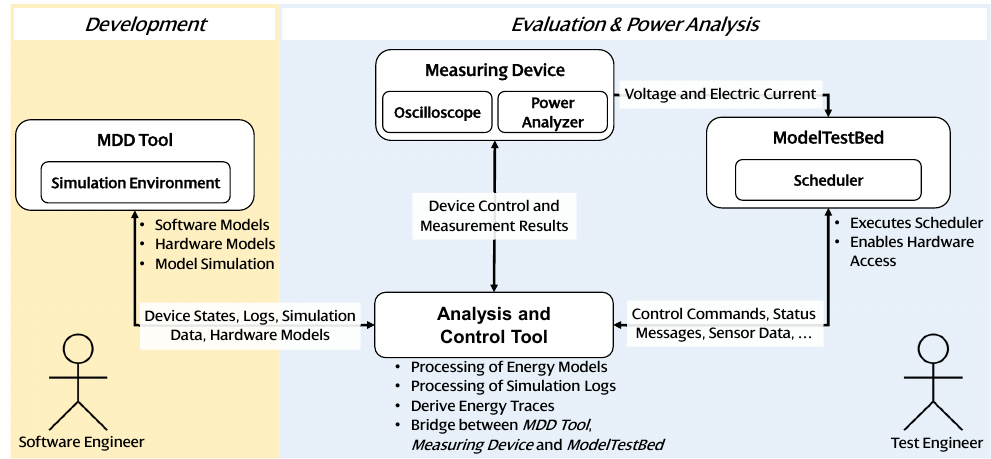
Figure 4. Direct power analysis (DPA) concept to derive energy traces based on interactions with a real hardware